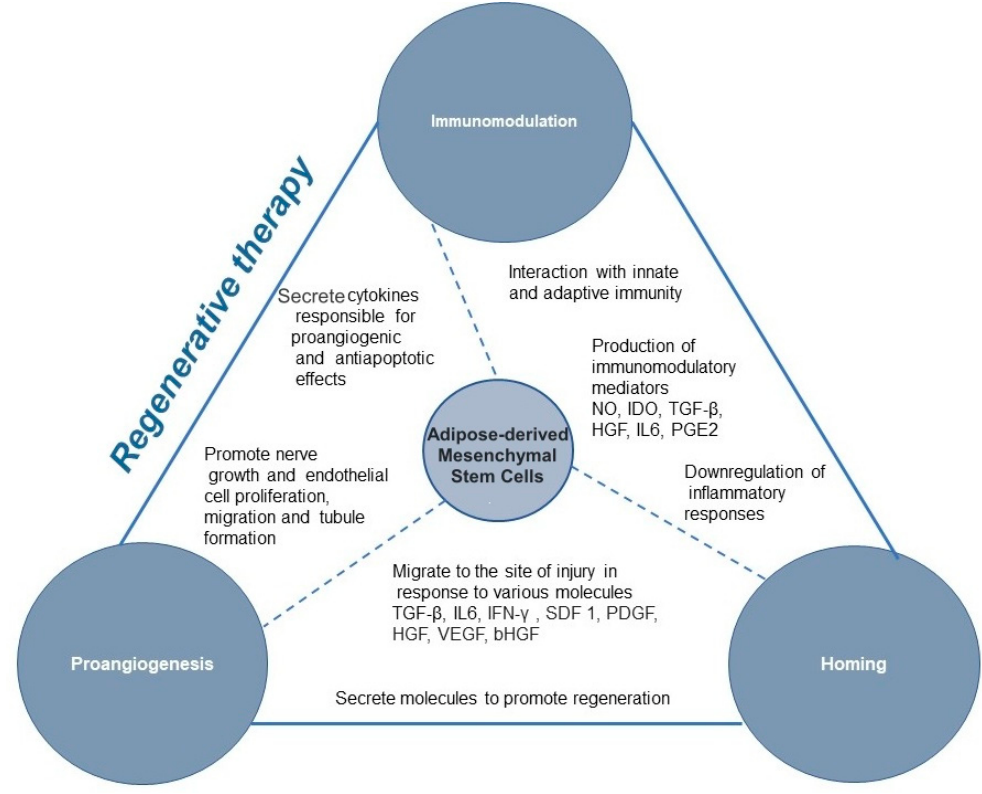
Figure 5. Schematic representation of adipose-derived mesenchymal stem cell features explored within regenerative therapy.